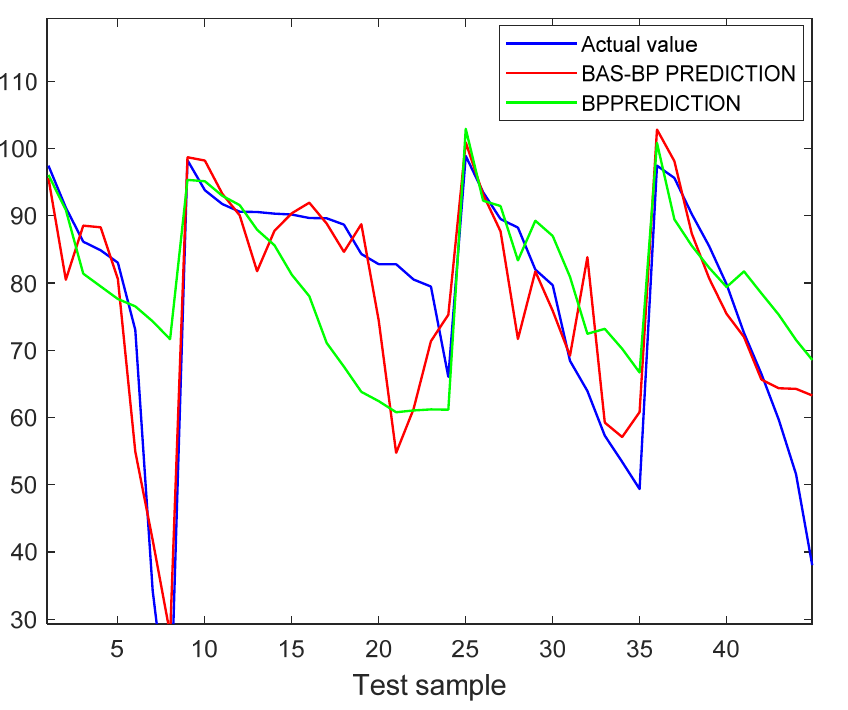
Figure 16. Fitness curve of BAS-BP neural network.